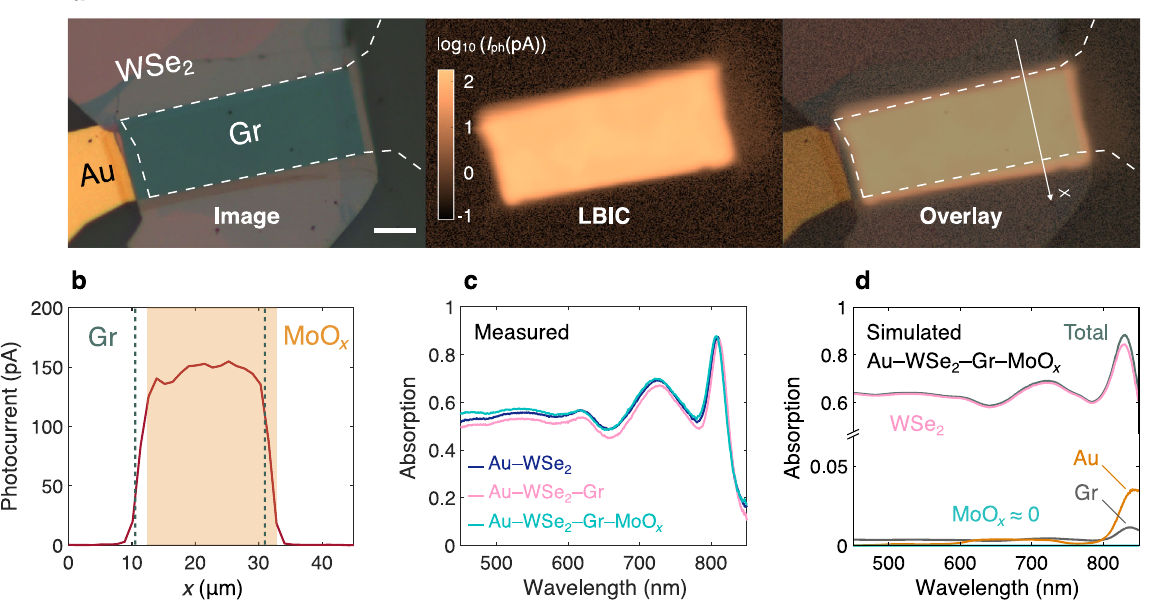
Fig. 3 Optical characteristics of fl exible WSe 2 solar cells. a Optical image (left), light beam-induced current (LBIC or photocurrent) map (middle), and their overlay (right) for a typical WSe 2 solar cell, measured at λ = 530 nm. Scale bar, 10 μ m. b Photocurrent pro fi le along the x axis shown in a , demonstrating that the Gr/MoO x – WSe 2 junction area accurately represents the active area of the solar cell. The misaligned MoO x is passivating the WSe 2 top surface 24 , leading to the current generation up to the edge of MoO x . The photocurrent tails beyond the edges of Gr and MoO x occur due to the fi nite laser spot size (~2 μ m). In most devices, MoO x and Gr are fully aligned like in Fig. 1c. c Measured absorption spectra at the center of the active area, taken at various stages of the fabrication process: after polyimide release (only with Au – WSe 2 ), Gr transfer, and MoO x deposition. d Simulated absorption spectra of the same device, matching well with the measurement in c . The plot also shows the contribution of each layer to the overall absorption. Nearly all absorption occurs within the 209-nm-thick WSe 2 absorber layer. Note the discontinuous vertical axis, used to magnify the smaller contributions.